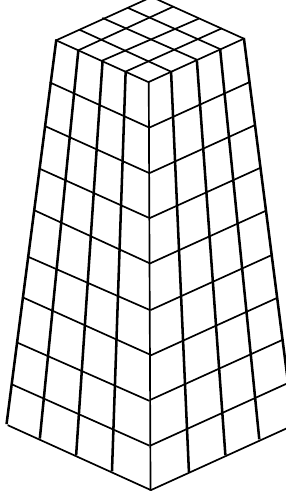
Figure 3. The new basis shape with a leaner relationship.